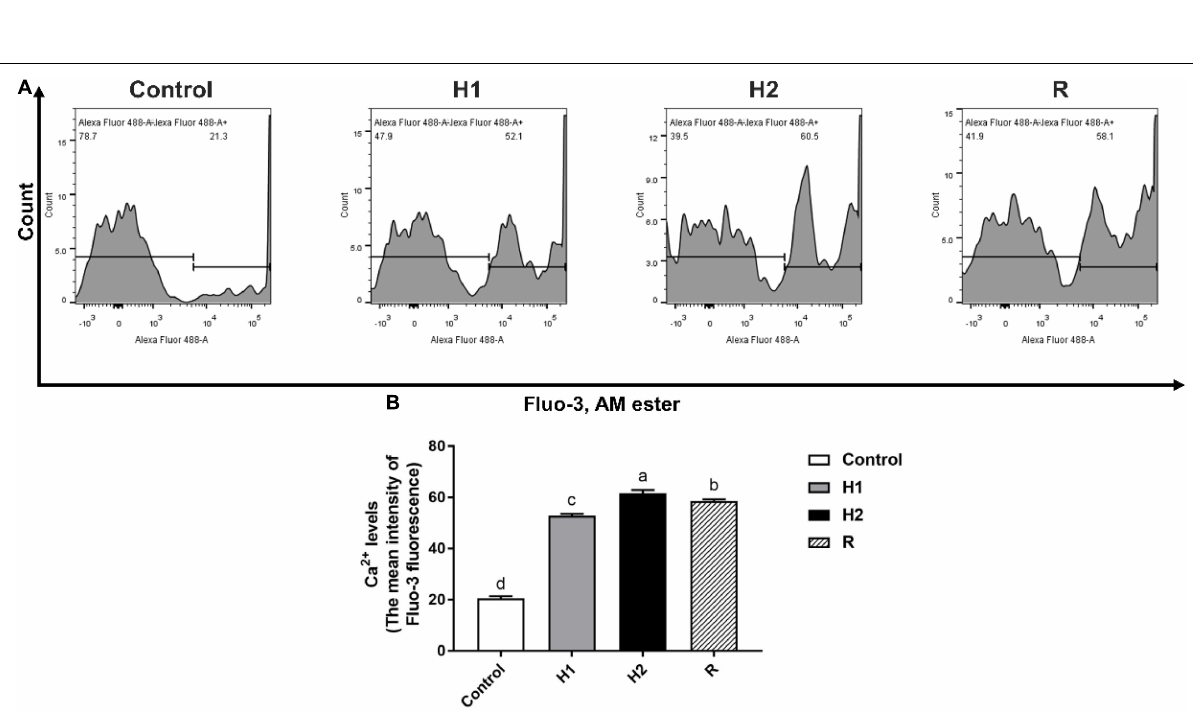
Frontiers in Ecology and Evolution |